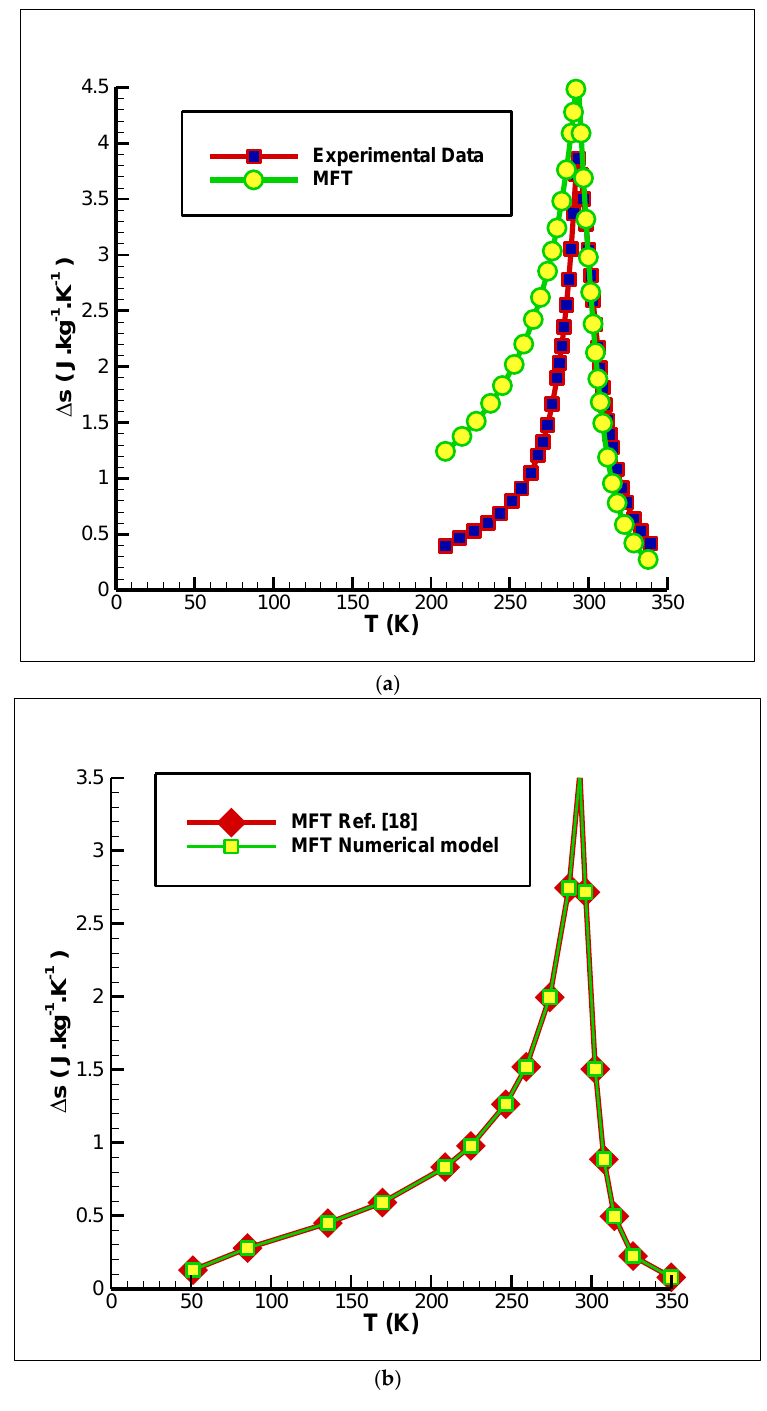
Figure 3. ( a ) the comparison of the isothermal entropy changes of Gd during the magnetization (0–1.5 T) and ( b ) the comparison of the isothermal entropy changes of Gd (0–1 T) in [18] which were obtained by mean field theory (MFT).